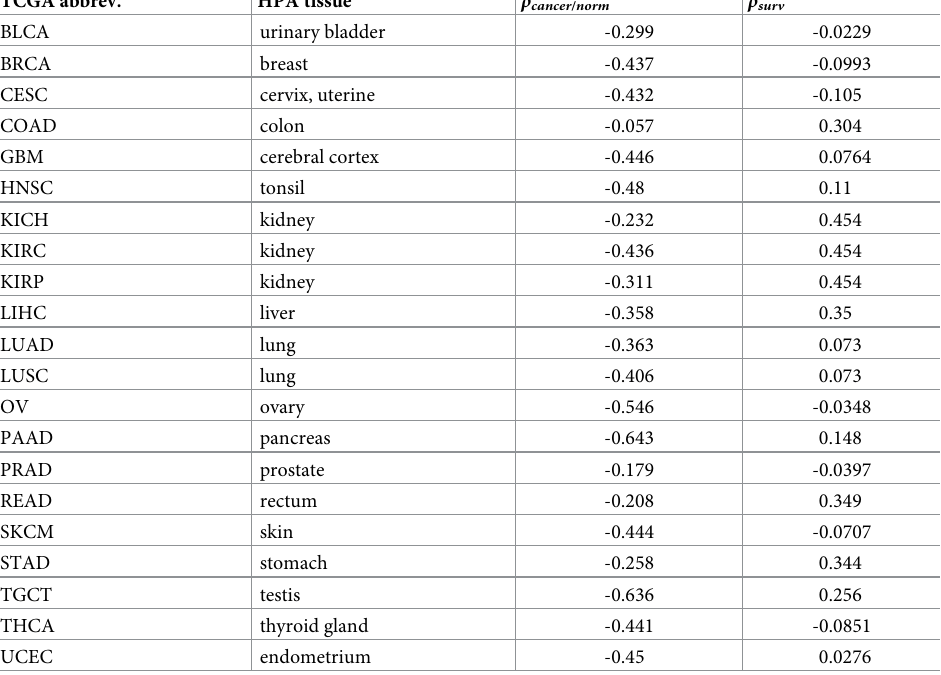
Table 4. Correlations between normal tissue-specific gene weights and either cancer/normal relative expression or an indicator of cancer prognostic ability. The ρ cancer / norm column holds the Spearman rank correlation between nor- mal tissue-specific gene weights ( n � ) and the log ratio of mean expression in the cancer type to mean expression in the i ; j normal tissue ( r i , j ). The ρ surv column holds the Spearman rank correlation between normal tissue-specific gene weights ( n � ) and the signed log of the p-value from a Kaplan-Meir test of the association between gene expression and cancer i ; j survival as computed by Uhlen et al. [18]) ( s , which is computed as -log(p-value) for favorable genes and log(p-value) i , j for unfavorable genes). TCGA